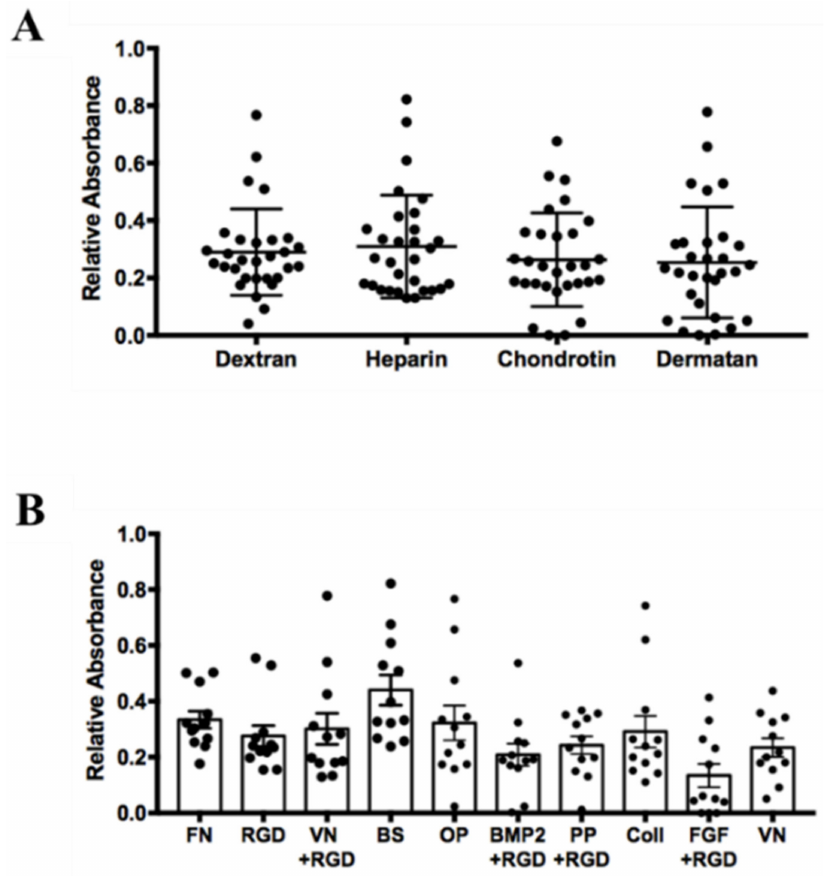
Figure 2. Identifying attachment substrates necessary for human adipose stem cells’ (hASCs) ad- herence to cell culture surface, spreading, and growth under serum-free conditions. Human ASCs obtained from three different donors were used to screen a 96-well plate coated with 24 different peptides non-covalently linked to four different highly sulphated glycosaminoglycans (GAGs: syn- thetic dextran sulfate, heparin, chondroitin, and dermatan) [47,48]. The cells’ growth in the 96-well plate was evaluated using a commercial colorimetric cell viability assay. ( A ) Values of relative ab- sorbance measured at 450 nm and classified according to the four types of sulphated GAGs (synthetic dextran sulfate, heparin, chondroitin, and dermatan) were used as a backbone for the formation of the different coating matrices. The four GAGs do not have a great influence on cell attachment and growth. ( B ) Ten different peptides non-covalently linked to highly sulphated GAGs strongly influence the ability of hASCs to attach and grow in the test micro-wells. The results obtained with the 14 poor-performing peptide-combinations are not shown. As in Figure 2A, cell proliferation was measured using a commercial colorimetric kit. Histograms show the means ± standard deviations of the measured relative absorbances for hASCs obtained from three different donors. FN = fibronectin; VN = vitronectin; BS = bone sialoprotein; OP = osteopontin peptide; BMP2 = bone morphogenetic protein; PP = perlacan peptide; ColI = collagen I peptide; FGF = fibroblast growth